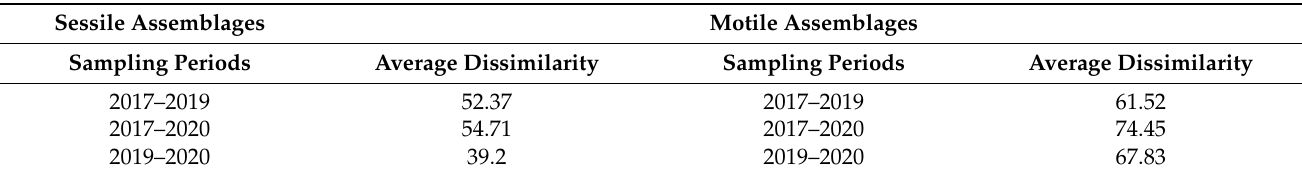
Table 1. Pairwise similarity percentage analysis (SIMPER), showing the pairwise average dissimilar- ity (%) among three sampling periods.